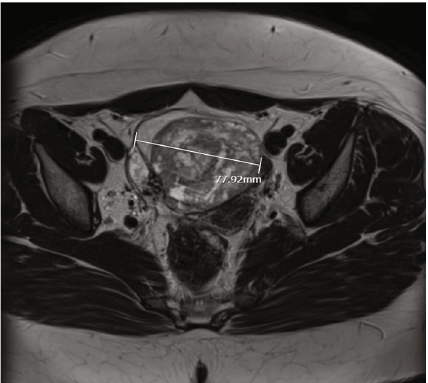
Figure 2: MRI fi ndings. Right adnexal mass with a solid and cystic appearance.